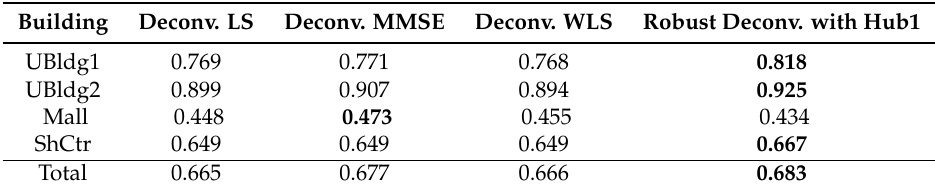
Table 4. Comparison of the floor detection probability for different deconvolution-based approaches. Columns 2–4 show the basic deconvolution approaches as introduced in [5], and the last column shows the robust deconvolution approach. The robust method outperforms all of the basic deconvolution approaches. MMSE: minimum mean-squared